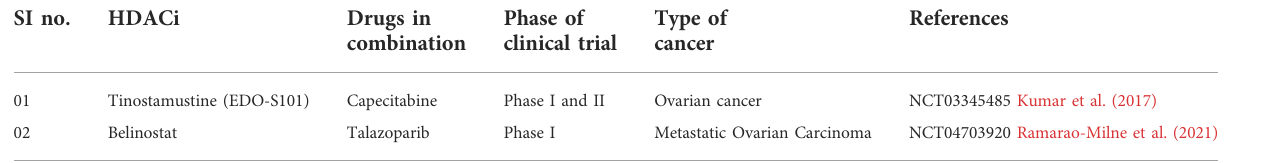
TABLE 7 Recent HDACi in clinical trials of ovarian cancer. SI